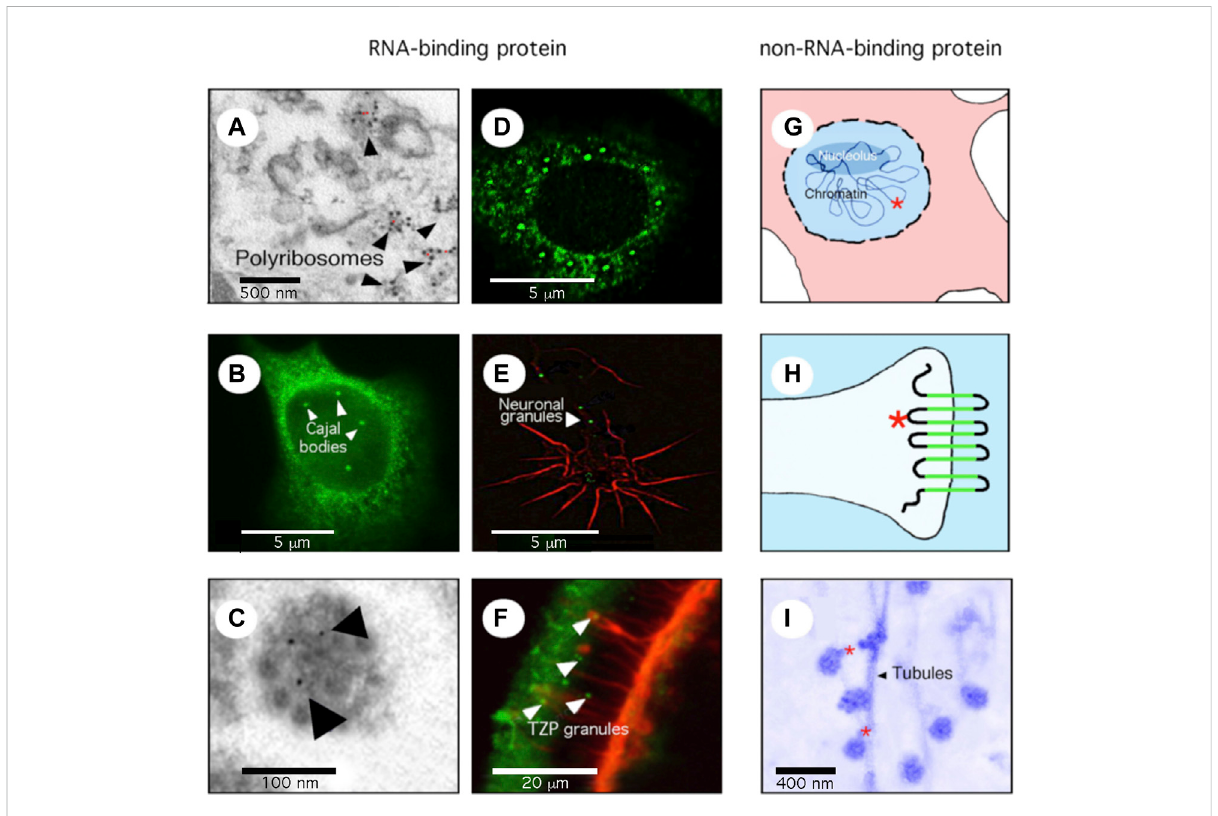
FIGURE 1 FMRP is a multifunctional protein. (A) the great majority of FMRP is associated with the translation machinery. Electron microscopy (EM) micrographyshowingFMRP (reddots)on polyribosomes. (B) A minorfraction ofFMRP, inthiscasethenuclearisoform 6,isdetected inCajal Bodies, site of splicing of pre-messenger RNA. (C) FMRP is present in compacted granules containing mRNA, travelling in neuronal dendrites/axons as seen by EM and immuno-gold labelling (indicated by arrows). (D) FMRP relocalizes to stress granules after arsenite treatments. (E) FMRP (green) in compacted granules delivered locally at the axonal growth cone (red). (F) FMRP (green) is present in RNA-granules translocated from cumulus cells totheoocytesthroughtranszonalprojections(red). (G) FMRP(redstar)isassociatedwithchromatinandisinvolvedinDNArepair. (H)